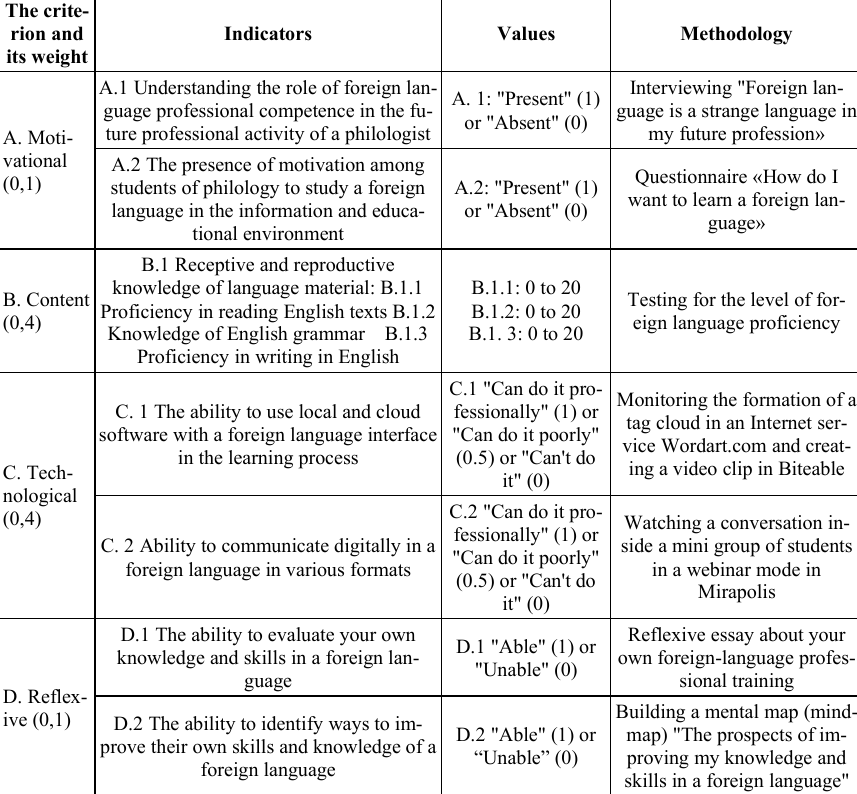
Table 2. Criteria, indicators, methods for diagnosing the initial level of training of professional competence in a foreign language The crite- rion